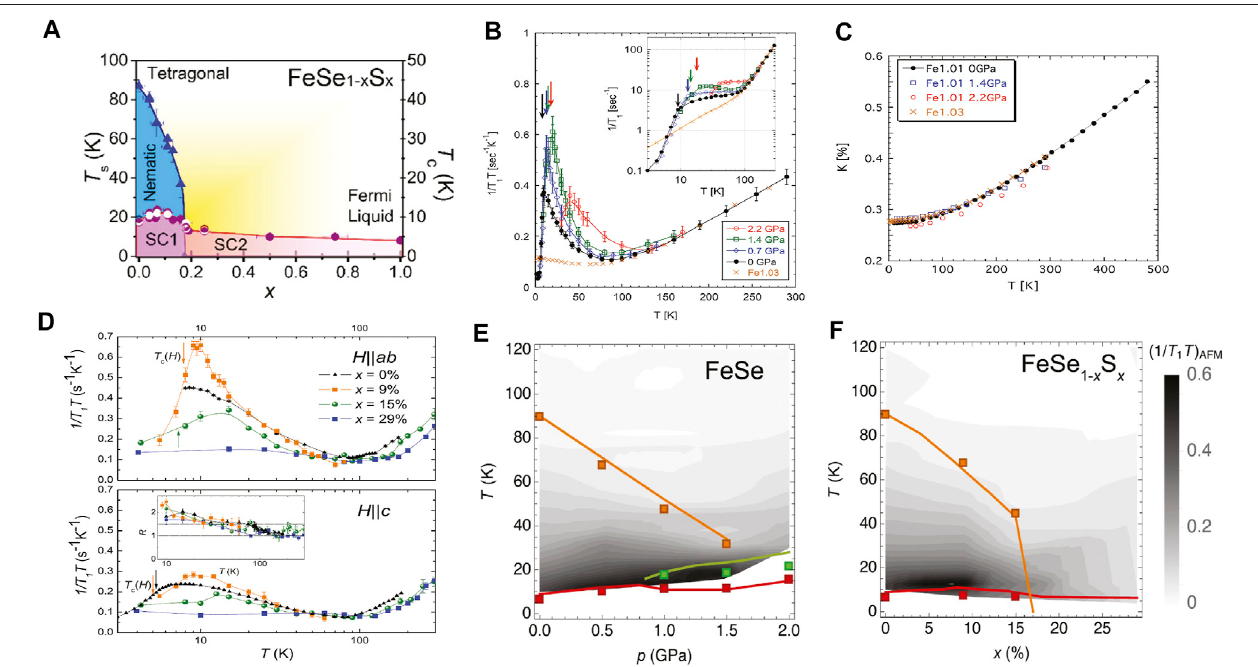
FIGURE 1 | (A) Electronic phase diagram of FeSe 1 − x S x taken from Ref. [25] based on data from Refs. [26, 27]. (B) T dependence of 1/ T 1 T under various p in polycrystalline FeSe. The arrows show the corresponding T c . The inset show the T dependence of 1/ T 1 under p . Reprinted with permission from T. Imai et al., Physical Review Letters 102, 177005, 2009 [17]. Copyright (2009) by the American Physical Society. (C) p dependence of the Knight shift K as a function of T . Reprinted with permission from Ref. [17]. Copyright (2009) by the American Physical Society. (D) T -dependence of 1/ T 1 T in single crystalline FeSe 1 − x S x for H (cid:1) ab (top) and H (cid:1) c (bottom) at ambient p . The arrows show the corresponding T c . The inset shows inset the T dependence of the ratio R = T 1, c / T 1, ab . Reprinted with permission from P. Wiecki et al. , Physical Review B 98, 020507(R), 2018 [18]. Copyright (2018) by the American Physical Society. (E, F) The contour plots of the amplitude of the AFM fl uctuations de fi ned as ( 1/ T ) 1 T AFM (see text for derivation) in single crystal: FeSe under p (E) and FeSe 1 − x S x at ambient p (F) taken from Ref. [18] which includes data reported in Refs. [58, 60]. The orange, red and green symbols show T s , T c , and T N , respectively, determined by NMR measurements under H ~ 7.4 T [18]. The colored curves are the corresponding values from literatures [58, 60]. Reprinted with permission from Ref. [18]. Copyright (2018) by the American Physical